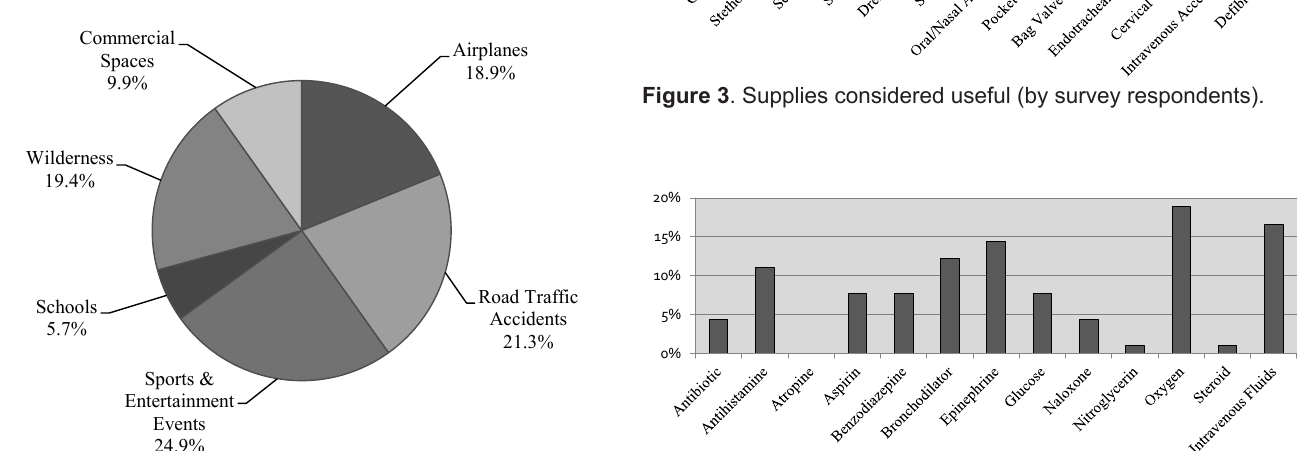
Figure 4 . Medications considered useful (by survey respondents) in the event of Good Samaritan